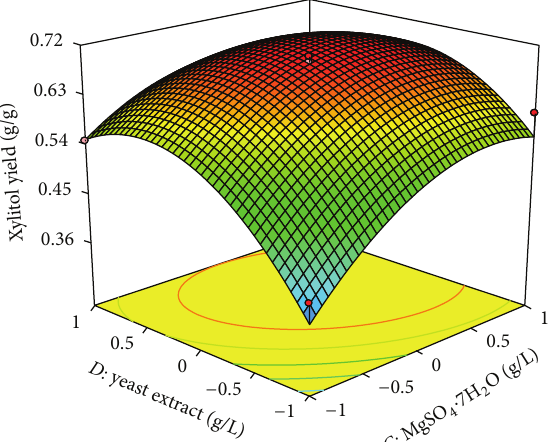
Figure 4: 3D plot showing the effect of MgSO 4 ⋅ 7H 2 O and yeast extract on xylitol